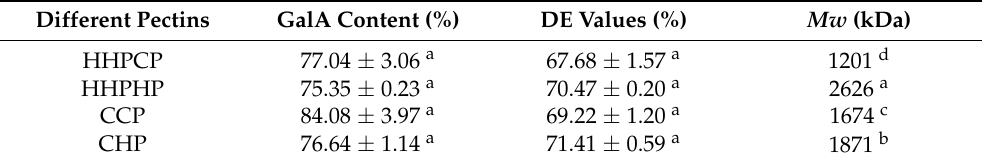
Table 1. Physiochemical properties of Satsuma mandarin peel pectin prepared from different methods. Different